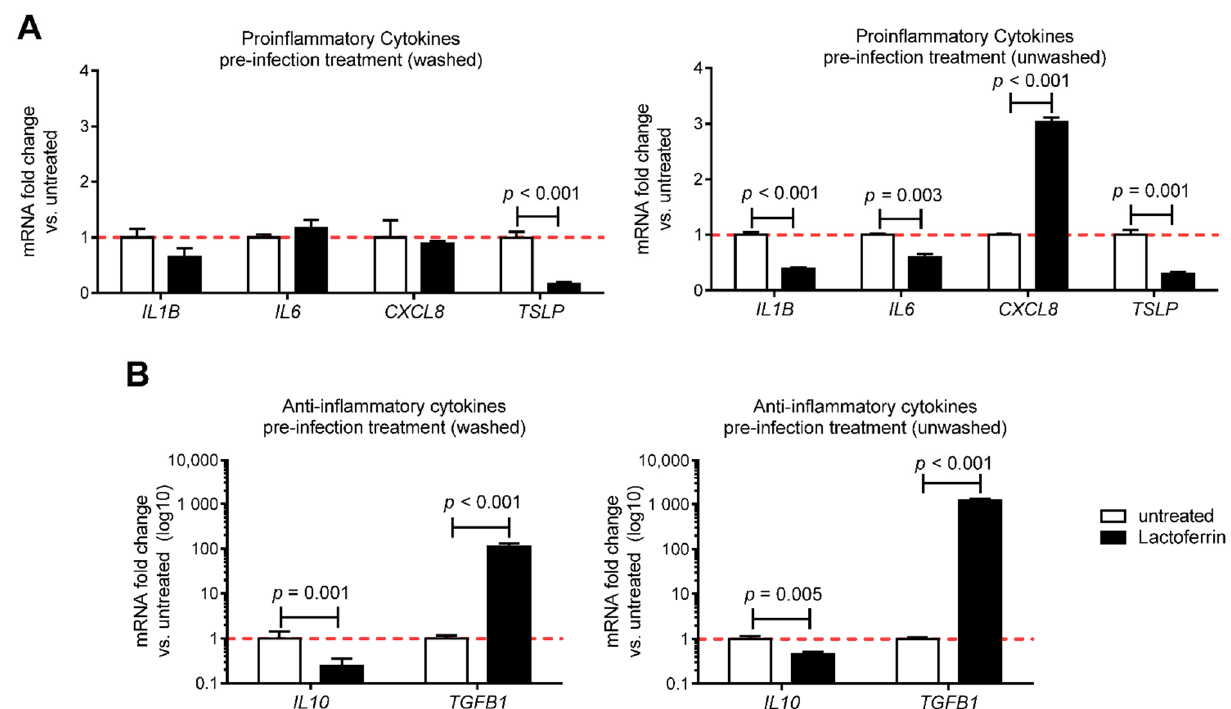
Figure 4. Lactoferrin modulates cytokine production resulting from SARS-CoV-2 infection in vitro. Caco-2 cells were treated or not for 3 h with 100 µg/mL lactoferrin and then infected with SARS-CoV-2 according to experimental design shown in Figure 1. Gene expression of ( A ) proinflammatory cytokines and ( B ) anti-inflammatory cytokines was assessed by real-time qPCR 24 h post infection (n = 3–6). Data are shown as relative fold changes compared to untreated (arbitrarily set as 1) and presented as mean + SD.